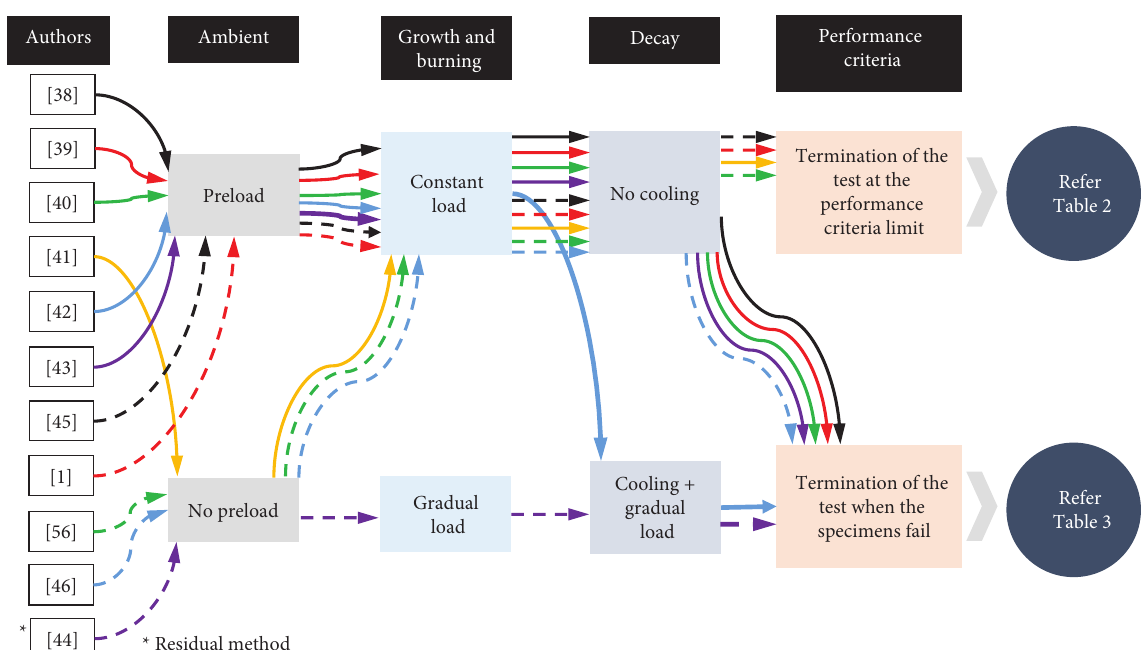
Figure 5: The load application and performance criteria for fire tests on beam-to-column connections.